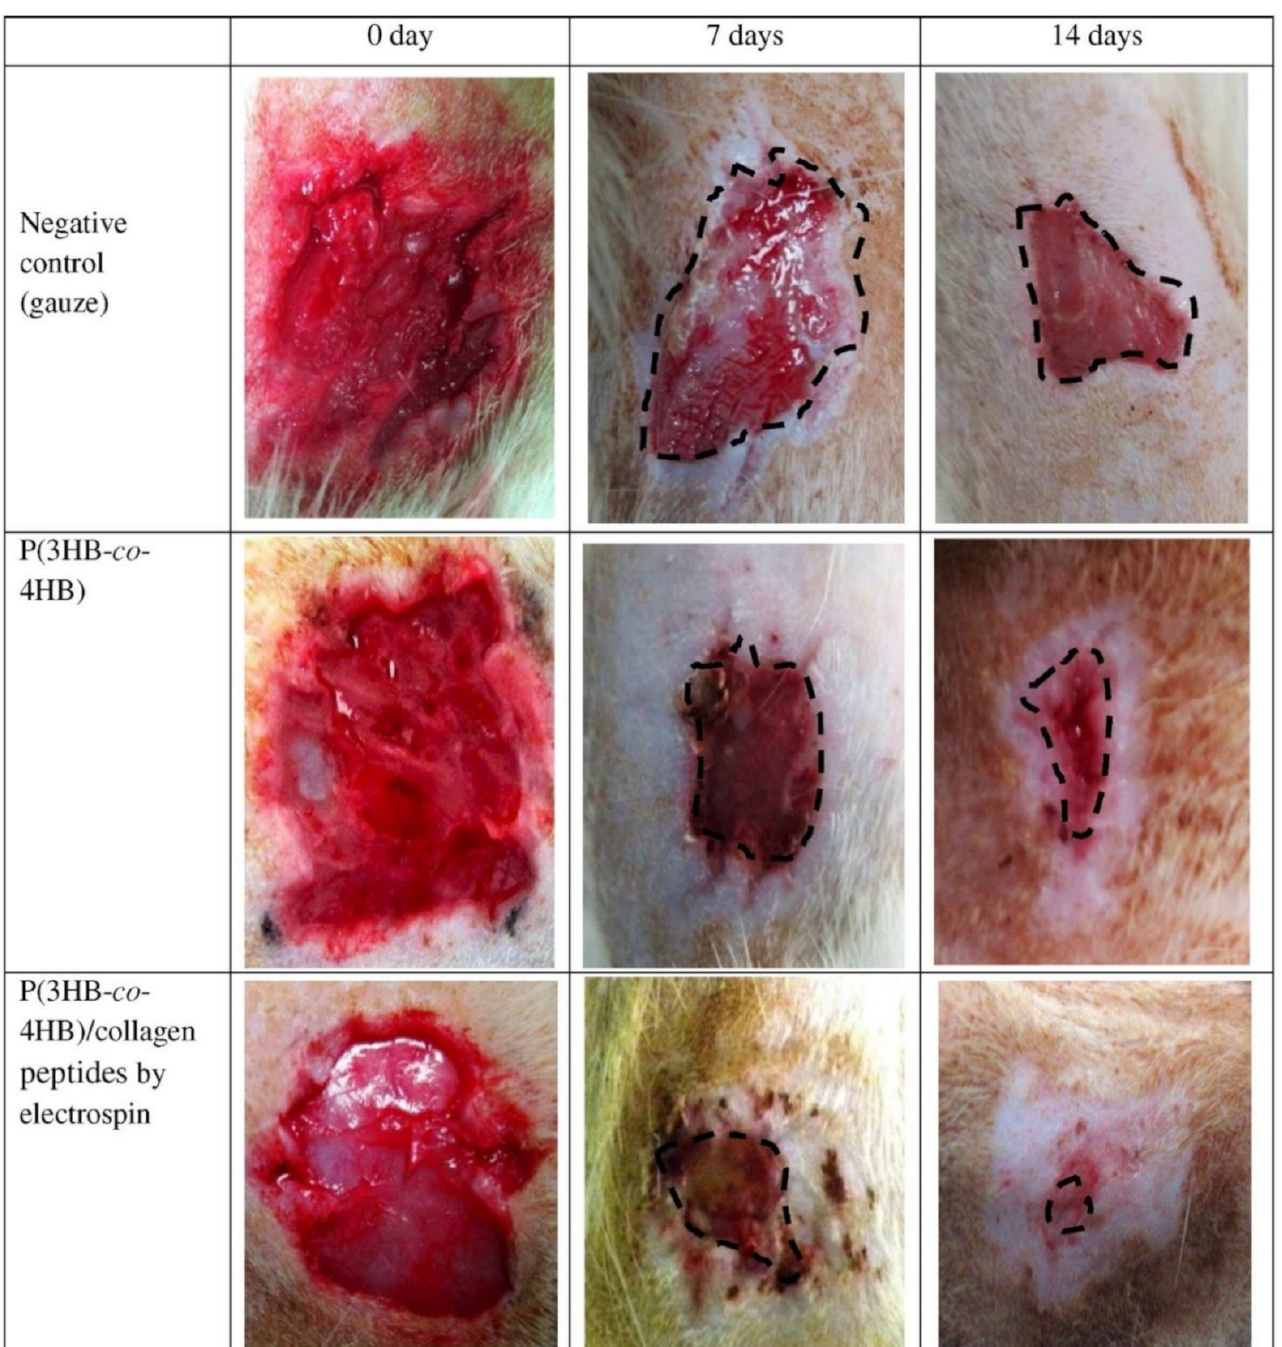
Figure 14. Photographs of wounded skin treated with various P(3HB-co-4HB) at different times. Reprinted from [161] with permission from